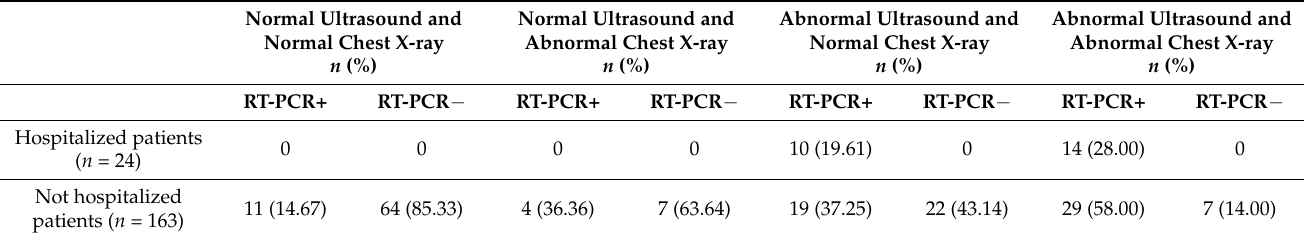
Table 3. Relationship between diagnostic findings and COVID-19 infection confirmed by PCR based on hospitalization. Normal Ultrasound and Normal Ultrasound and Abnormal Ultrasound and Abnormal Ultrasound and Normal Chest X-ray Abnormal Chest X-ray Normal Chest X-ray Abnormal Chest X-ray